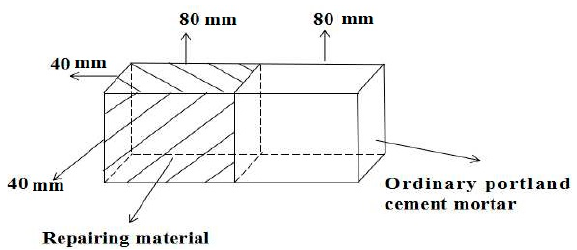
Figure 2. Specimen for the measurement of bonding strength.